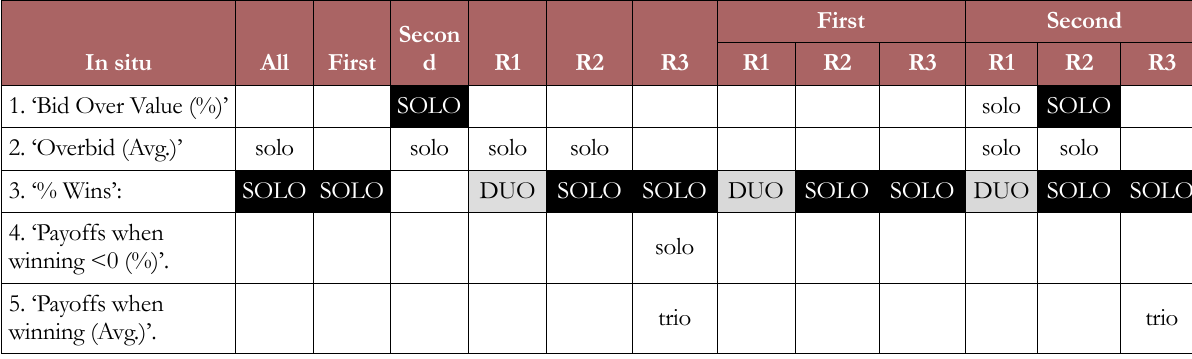
Table 9. Summary of comparisons with real